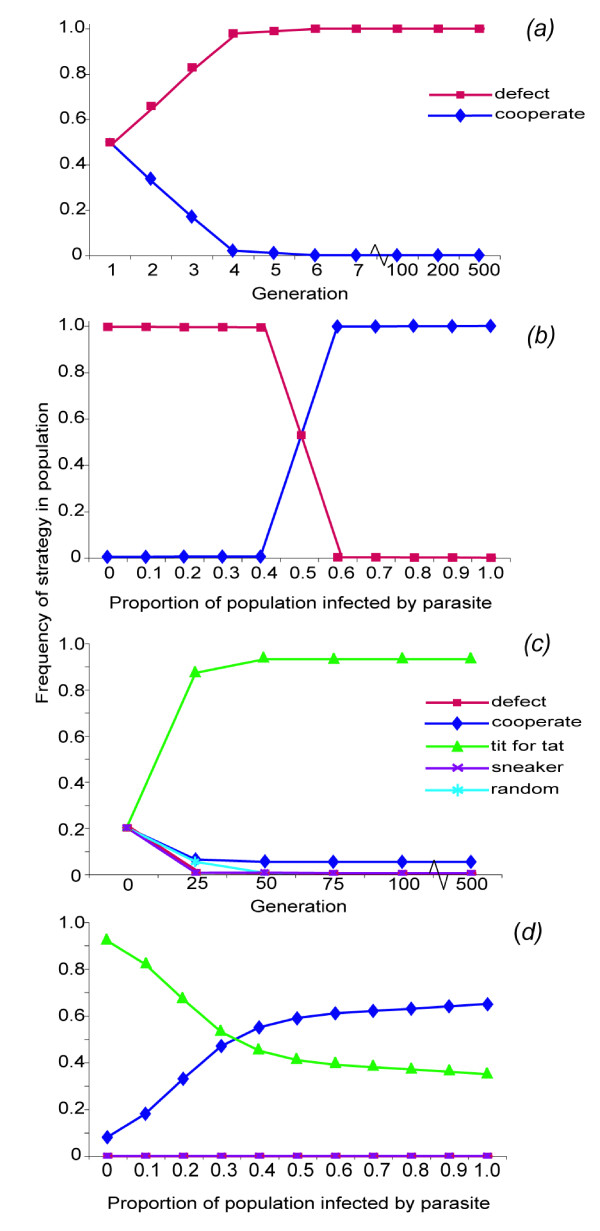
Prisoner's Dilemma simulations. Graphical output from DILEMMA, a computer program simulating the Iterated Prisoner's Dilemma (IPD) with the ability to incorporate parasites into the classic model to determine how prevalent parasite would need to be within populations to help favour cooperation over cheating. A) In the traditional IPD, the strategy "always defect" quickly eliminates the purely cooperative strategy "always cooperate" from the population. B) When parasitism is introduced into the population, "always cooperate" becomes a dominant strategy when infection rates are greater than 50% in the population. C) Strategies that combine cooperation with retaliation, such as "tit for tat", are successful in a heterogeneous population of strategies in the IPD (strategies defined in Supplementary Table 2). D) In the presence of parasites, "always cooperate" becomes a viable and dominant strategy in a heterogeneous population at parasitism levels as low as 35%. Output was generated using populations of 10,000 individuals, which engaged in 25 interactions per generation, for 500 generations. Each graph depicts the mean of 100 independent runs of the DILEMMA program. Standard error (SE) bars are not shown because values are less than 4.92 × 10-3, with the exception of the data points at 0.5 parasitism (b), which have SEs of 0.479.